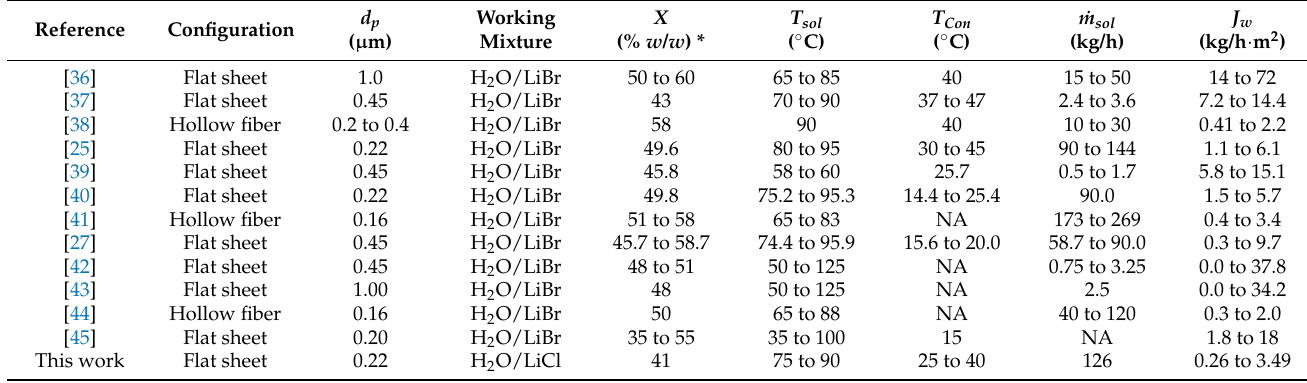
Table 5. Comparison of the experimental desorption rates for membrane desorbers reported in the literature.